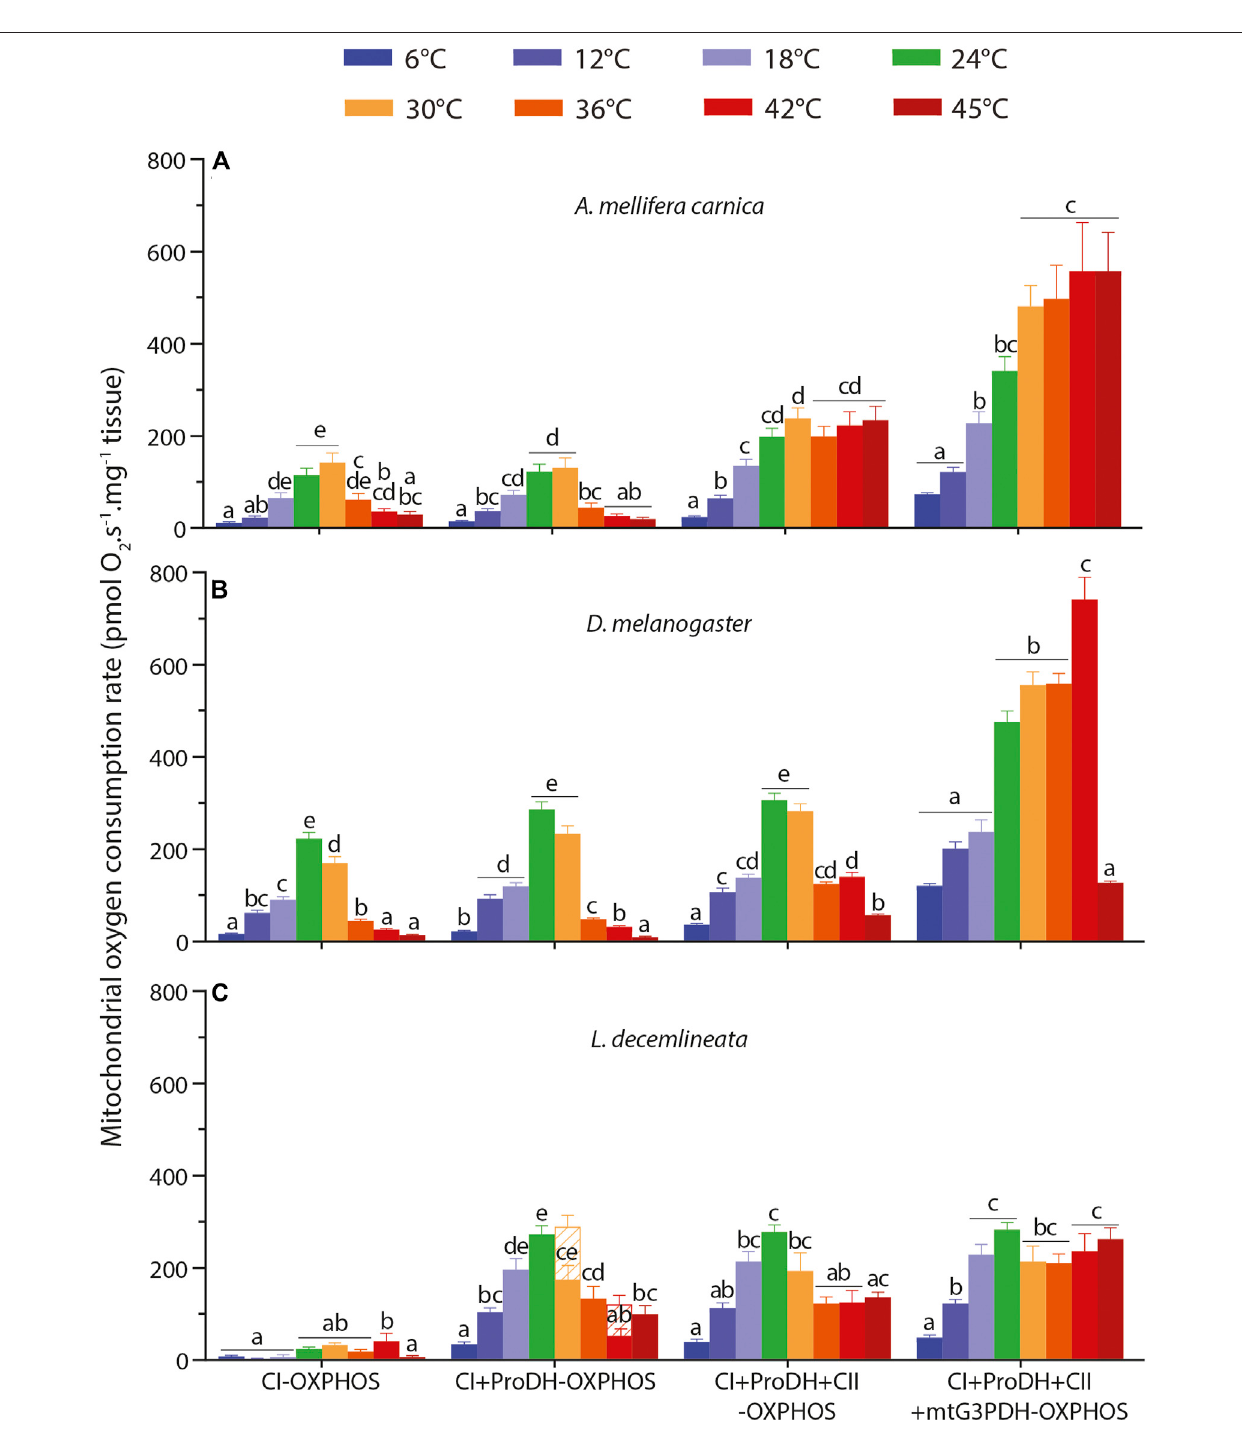
FIGURE1| Thermalsensitivityofmitochondrialoxygenconsumptionrate(OCR)measuredfrom6to45 ° Cinpermeabilizedthoracesofthethreeinsectspecies. (A) A. mellifera carnica ( n = 7 – 10), (B) D. melanogaster ( n = 5 – 10) and (C) L. decemlineata ( n = 5 – 10). OCRs were measured with pyruvate + malate (+glutamate in honeybees) +ADP (CI-OXPHOS), +proline (CI + ProDH-OXPHOS), +succinate (CI + ProDH + CII-OXPHOS), +G3P (CI + ProDH + CII + mtG3PDH-OXPHOS). OCRs are reported as mean ± s.e.m. and were compared within each species between assay temperatures using a one-way ANOVA followed by a HSD (Honest Signi fi cant Difference)Tukey ’ stest.Dissimilarlettersindicatesigni fi cantdifferencesbetweenOCRs.ForCI+ProDH+CII-OXPHOSinbeetles,one-wayANOVAconditionswerenot met,and anon-parametric test (Kruskall-Wallis) followed byaDunn ’ s test wereperformed.Whenassessingrespiration levels for L. decemlineata , OCRs at 30 and 42 ° C did not stabilize after proline addition (CI + ProDH-OXPHOS), not allowing the estimation of a reliable respiration rate. In this case, the respiration rate was taken 10 min after the start of the O 2 consumption decrease (represented with hatched bars) and another one was taken just prior to the addition of the next substrate, succinate. In this case, only the second rate was used for the calculations and the comparisons.